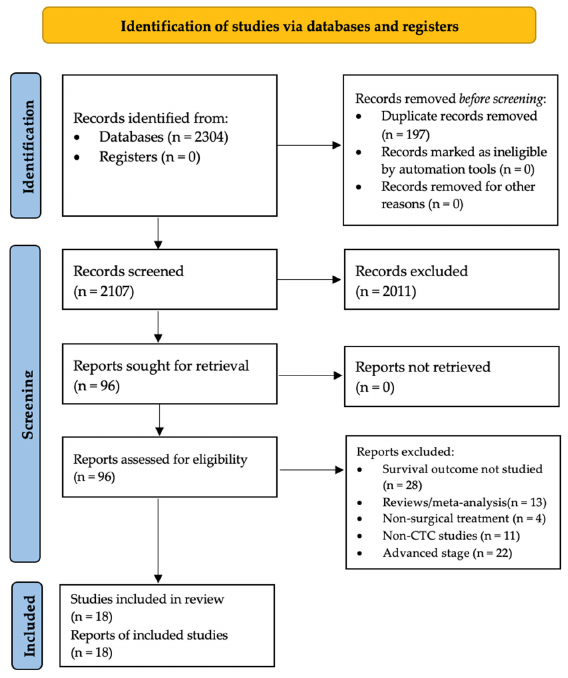
Figure 1. Flow diagram of study selection. The flow diagram is presented according to the Preferred Reporting Items for Systematic Reviews and Meta-Analyses (PRISMA) guidelines.